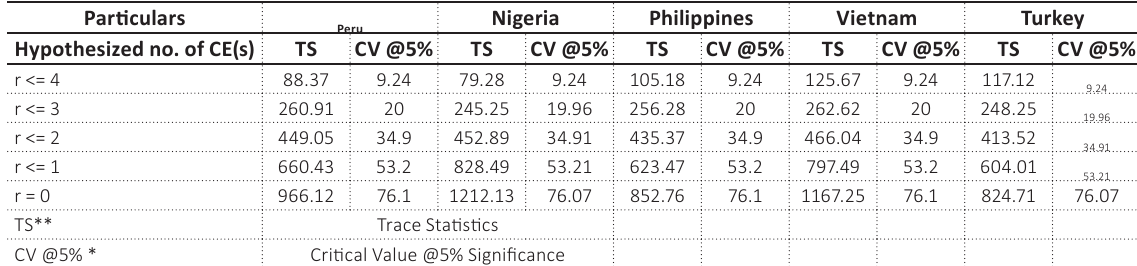
Table 4. Johansen co-integration test results country-wise: trace statistics without linear trend and constant in